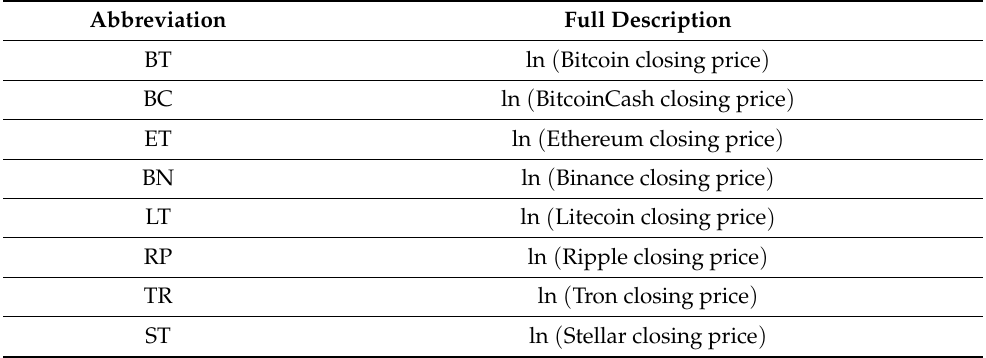
Table 1. Abbreviations Used In The